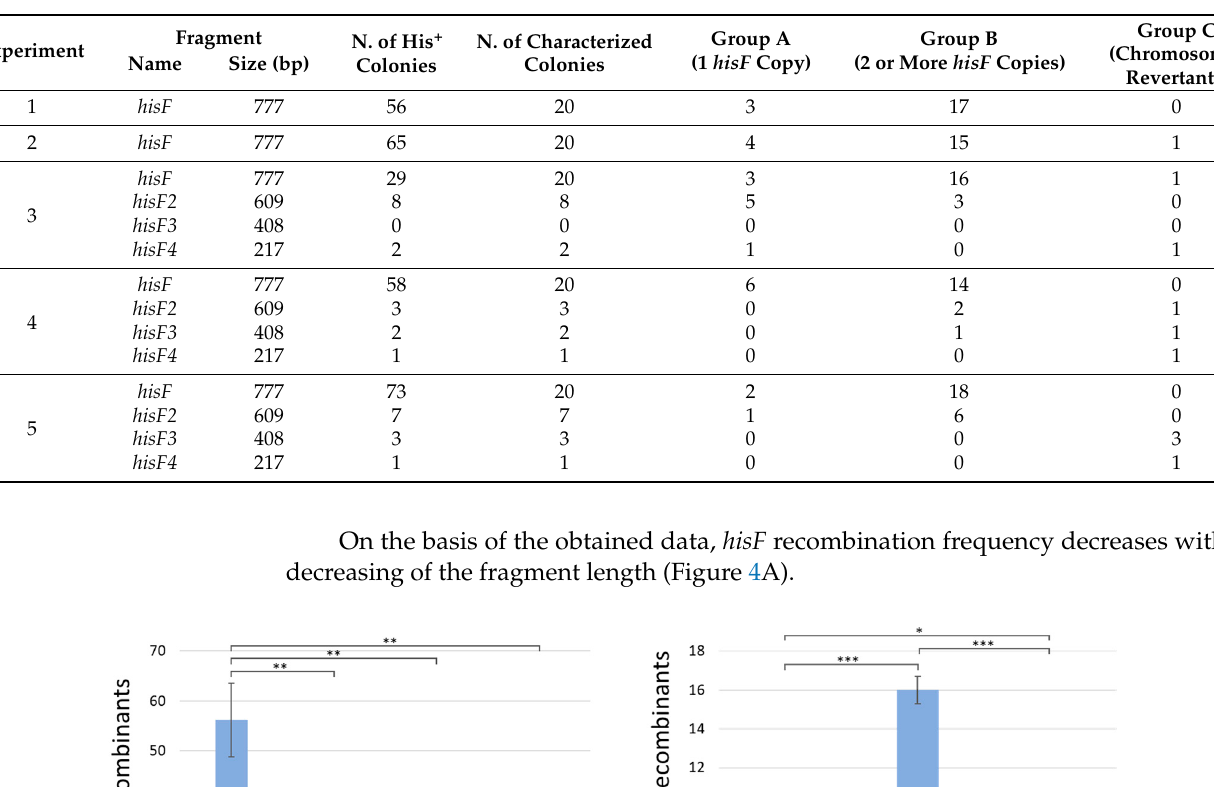
Table 4. Summary about His + colonies obtained after five CFGE experiments.